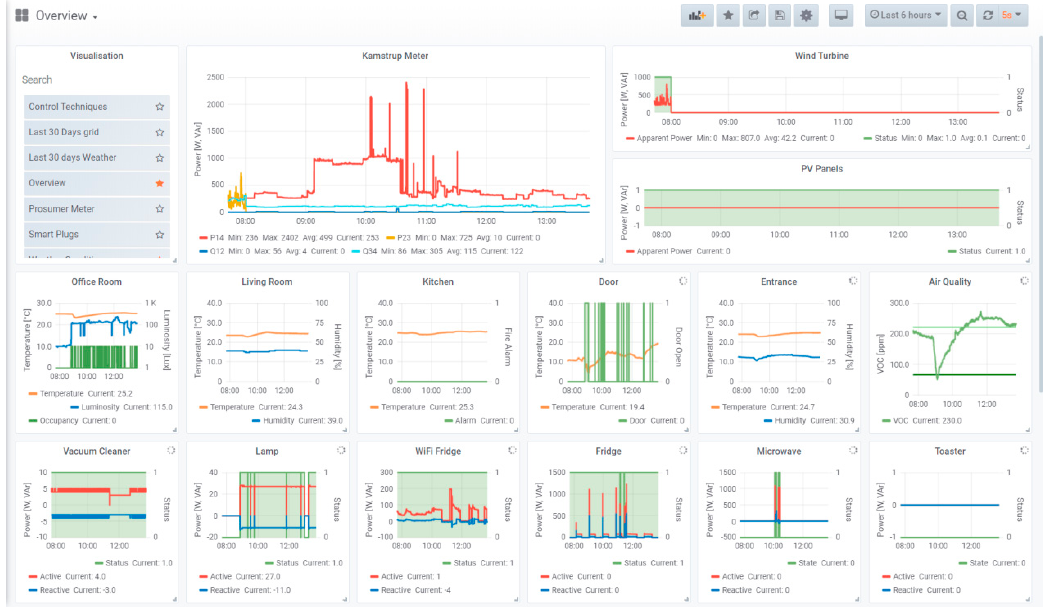
Figure 11. The Data Visualization Portal of IoT-MGLab.